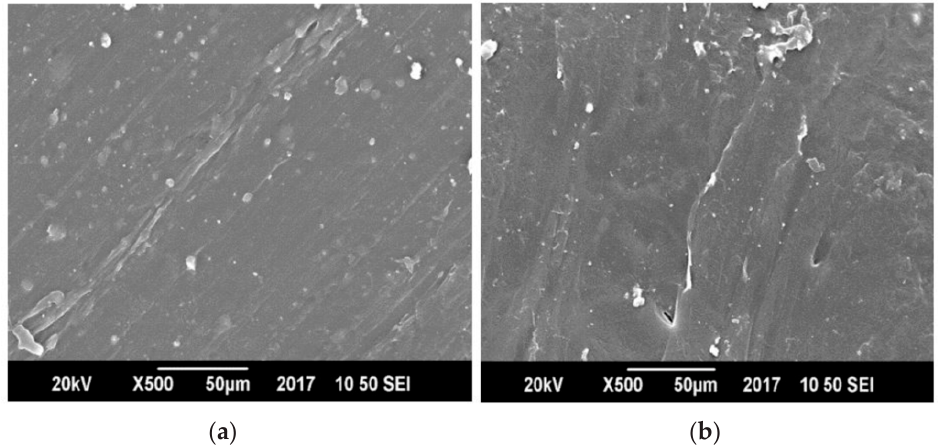
Figure 9. Scanning Electron Microscopy (SEM) images of ( a ) pure polyethylene Terephthalate (PET) and ( b ) pure polypropy- Figure 9. SEM images of ( a ) pure PET and ( b ) pure PP. lene (PP). Figure 9. SEM images of ( a ) pure PET and ( b ) pure PP.